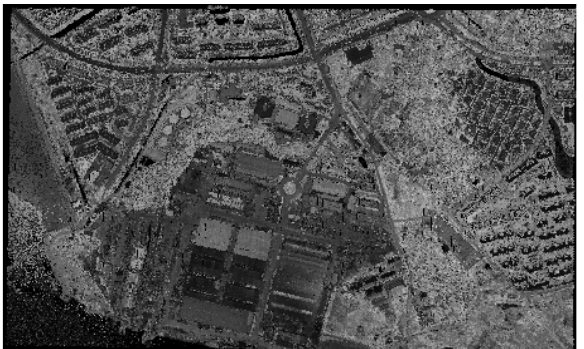
Figure 1. Intensity image of the first dataset